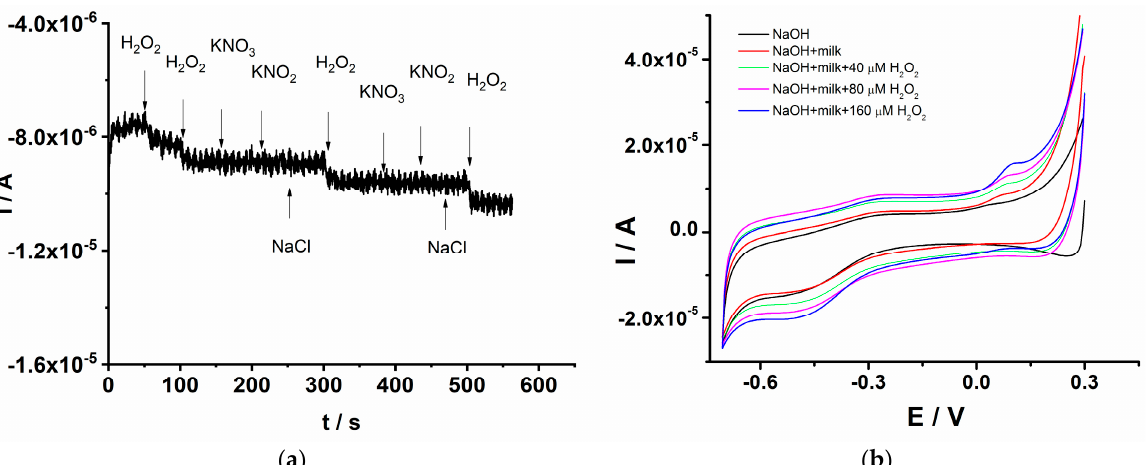
Figure 11. ( a ) Chronoamperogram for H 2 O 2 selective detection for the GCE/PEDOT-CuONPs sensor in the presence of various interfering compounds. ( b ) Cyclic voltammograms recorded for the GCE/PEDOT-CuONPs sensor in a diluted milk sample and in the presence of various amounts of H 2 O 2 . Potential scan rate: 50 mV/s.